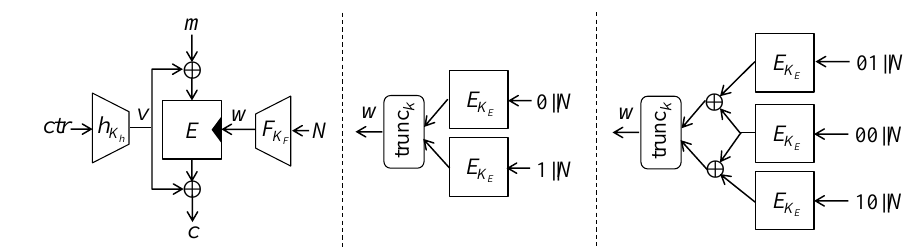
Figure 2: XKX (left), F (1) (center), F (2)